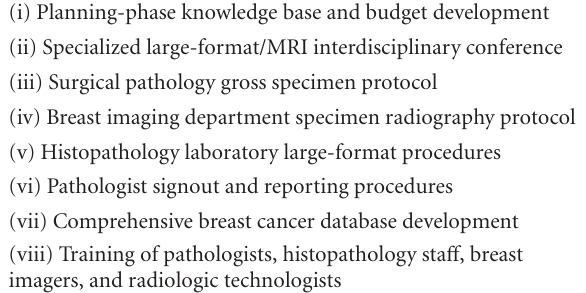
Table 3: Required program elements of the image-assisted large- format breast pathology